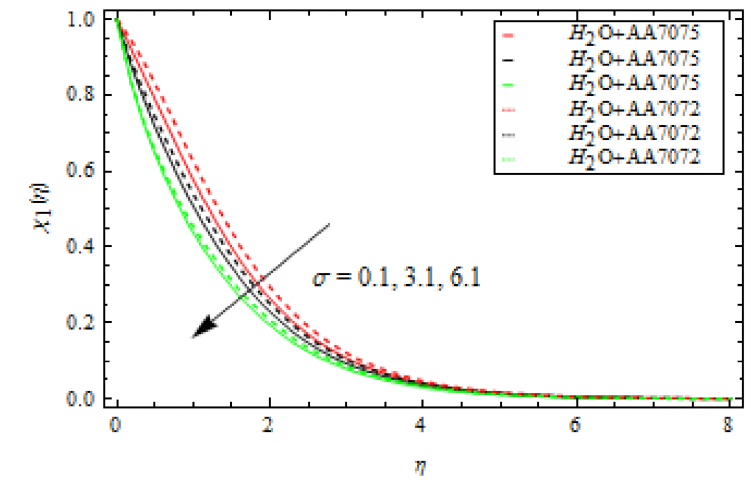
Figure 13. Influence of reaction rate parameter σ on concentration profile.